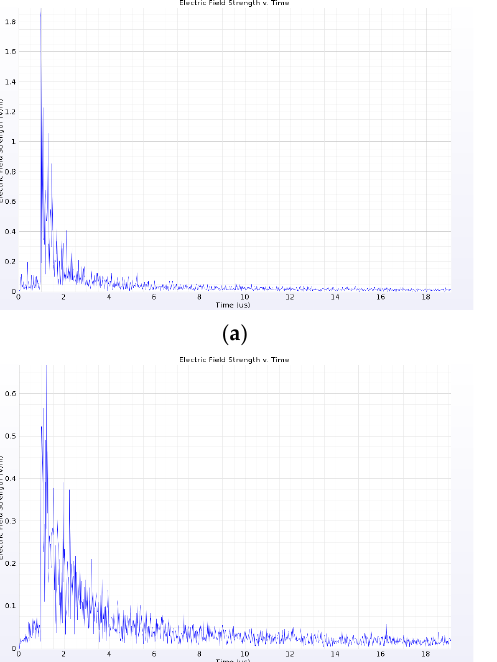
Figure 11. Location distribution of source and point sensors around busbar .